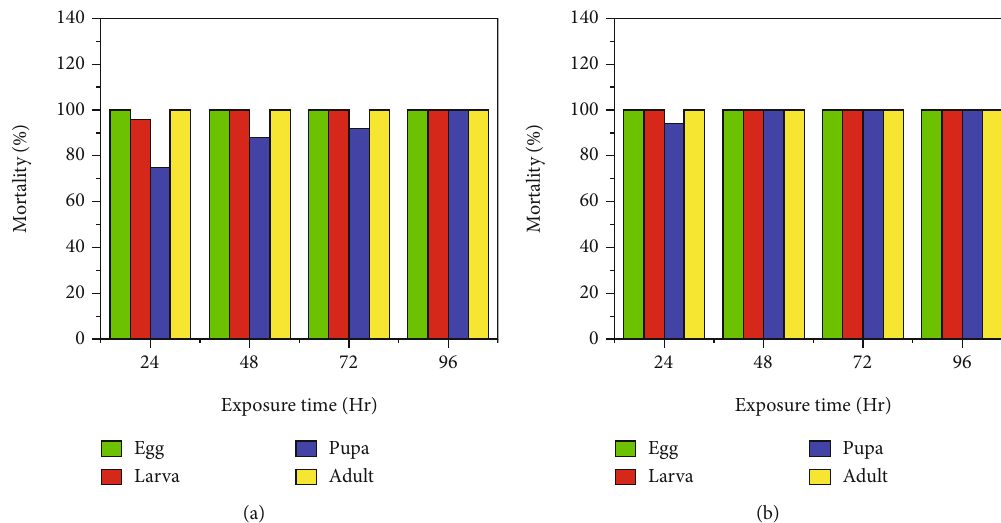
concentration and (b) 80% CO 2 and gunny bag storage. 2